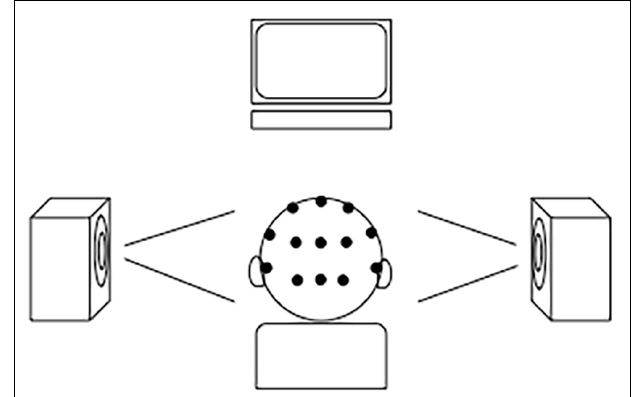
FIGURE 1 | Experimental setup of Swedish